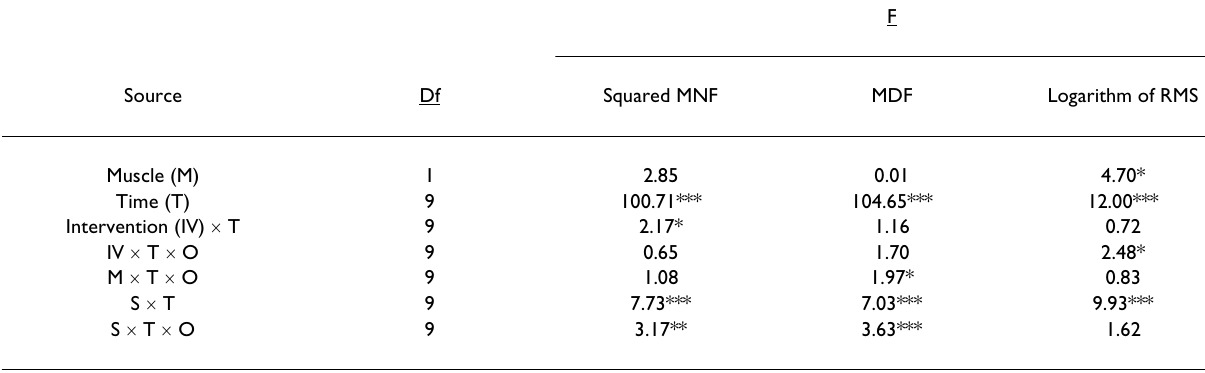
Table 2: Summary of Analysis of EMG Measures (N =